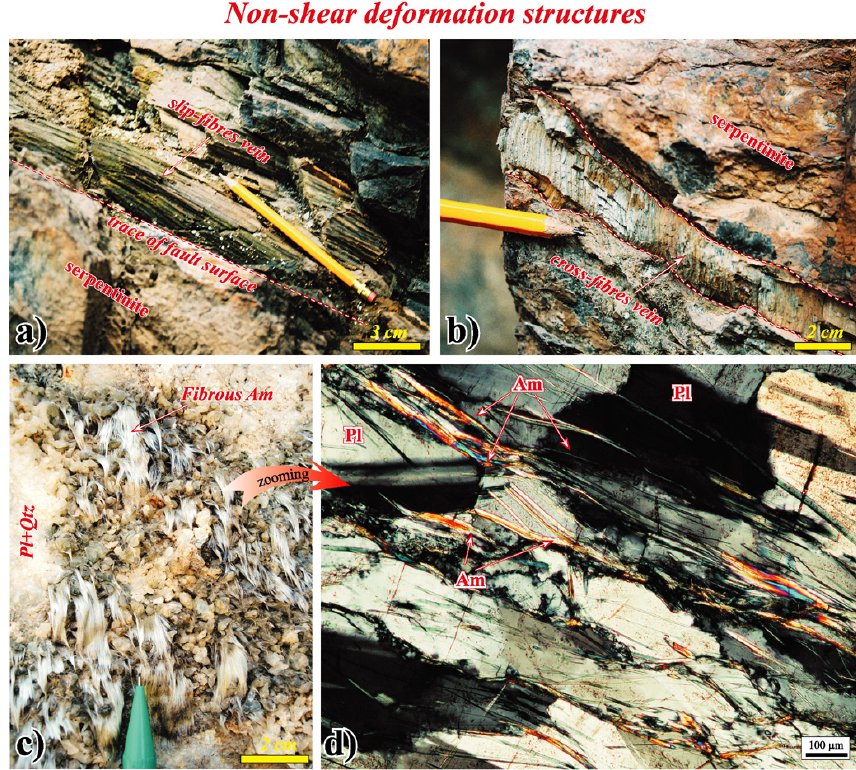
Fig. 6. Examples of non-shear deformation structures in ophiolites. (a) Antigorite slip-fibre and (b) antigorite cross-fibre veins in massive serpentinites; (c) tensile fracture in massive metagabbro with filling mineralisation composed by quartz, plagioclase, and fibrous amphiboles; (d) microphoto of thin section from fracture in (c) , showing a plagioclase texture hosting fibrous amphibole crystals. Mineral abbreviations: Am: amphibole; Pl: plagioclase; Qtz: